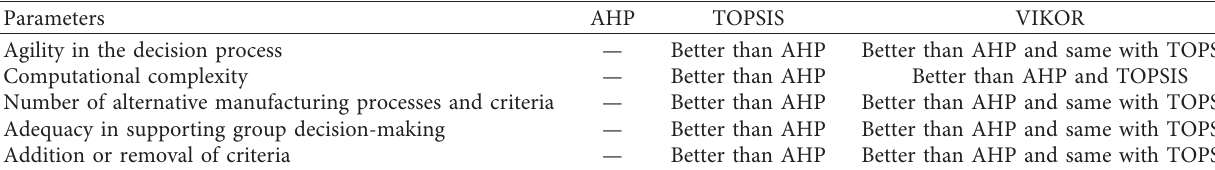
Table 15: Comparative analysis of AHP, TOPSIS, and